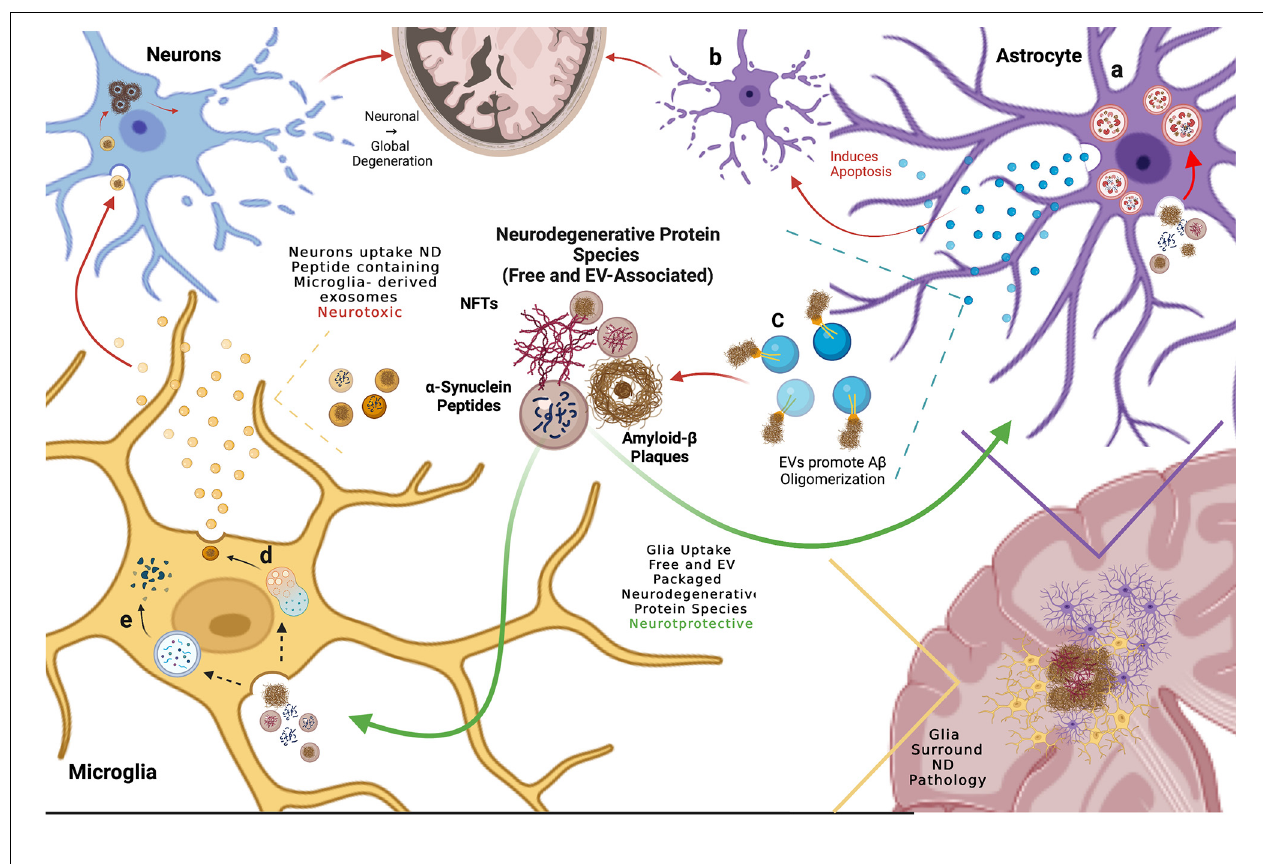
FIGURE 3 | Glial cells mediate propagation of neurodegenerative protein species by up-taking both free and extra-cellular vesicle (EV)-associated proteins, thereby preventing neuronal uptake and spread of disease. (A) Astrocytes endocytose free and EV-associated aggregate prone proteins including α -syn and A β and process them in the lysosome but subsequent lysosomal dysfunction results in debris-burdened enlarged lysosomes that do not degrade the engulfed material. (B) When exposed to A β , astrocytes release EVs that induce apoptosis in neighboring astrocytes. (C) Astrocytes also release EVs enriched in glycosphingolipids (GSLs) that bind monomeric A β , promoting oligomerization and plaque formation. (D) Microglia uptake both free and EV-associated aggregate-prone proteins and process them through the endolysosomal system where they are repackaged into EVs that are released and engulfed by neighboring neurons, presenting evidence of neurotoxic propagation from glia to neurons. (E) Microglia degrade endocytosed pathogenic proteins via phagocytosis, clearing aggregate prone